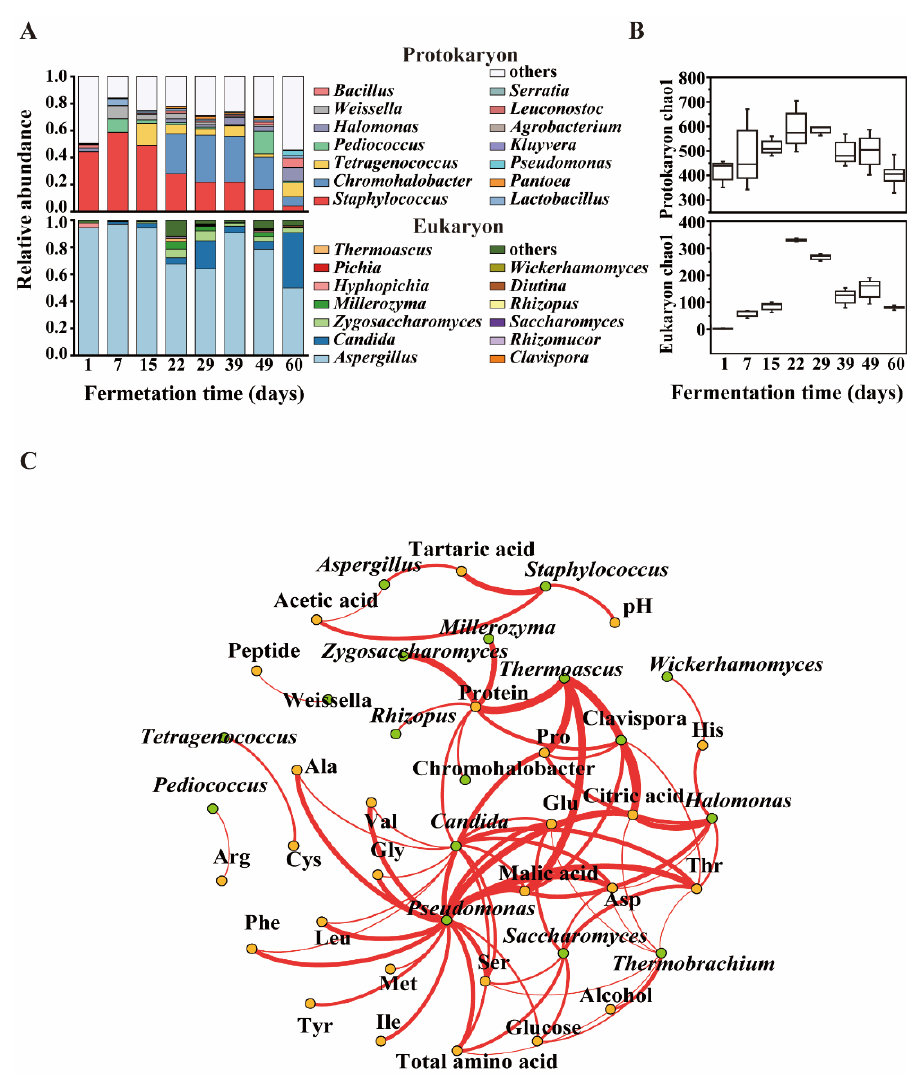
Figure 4. Correlation analysis suggests the potential functional microbiome for amino acid production during hypertonic moromi fermentation. ( A ) The dynamic succession of microbiota in moromi; ( B ) alpha diversity (Chao1) of moromi microbiota; ( C ) Spearman correlation network between the microbes and production of amino acids and organic acids. All edges represent significant correlations ( p < 0.05). The thickness of a line is highly related to the value of Spearman’s correlation ( | ρ | > 0.6, p < 0.05). Green dots represent microbial genera; Orange dots represent amino acids or organic acids. Red edges mean positive correlation.